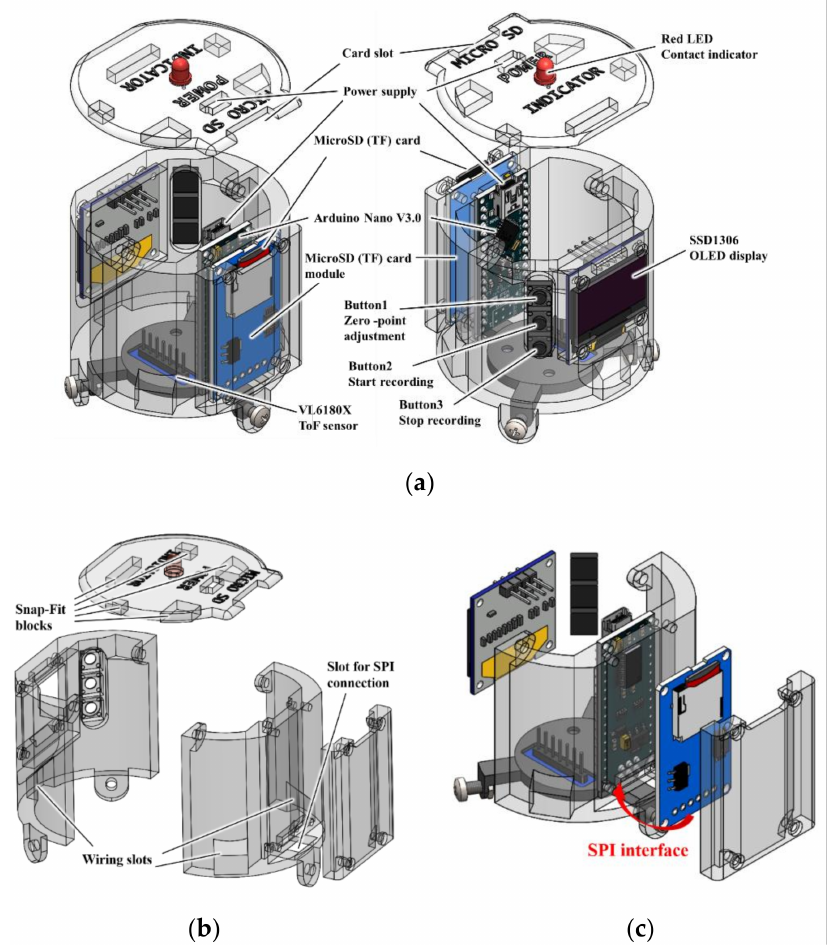
Figure 6. ( a ) Core control part and its composition structure. ( b ) Exploded figure of upper part. ( c ) SPI interface